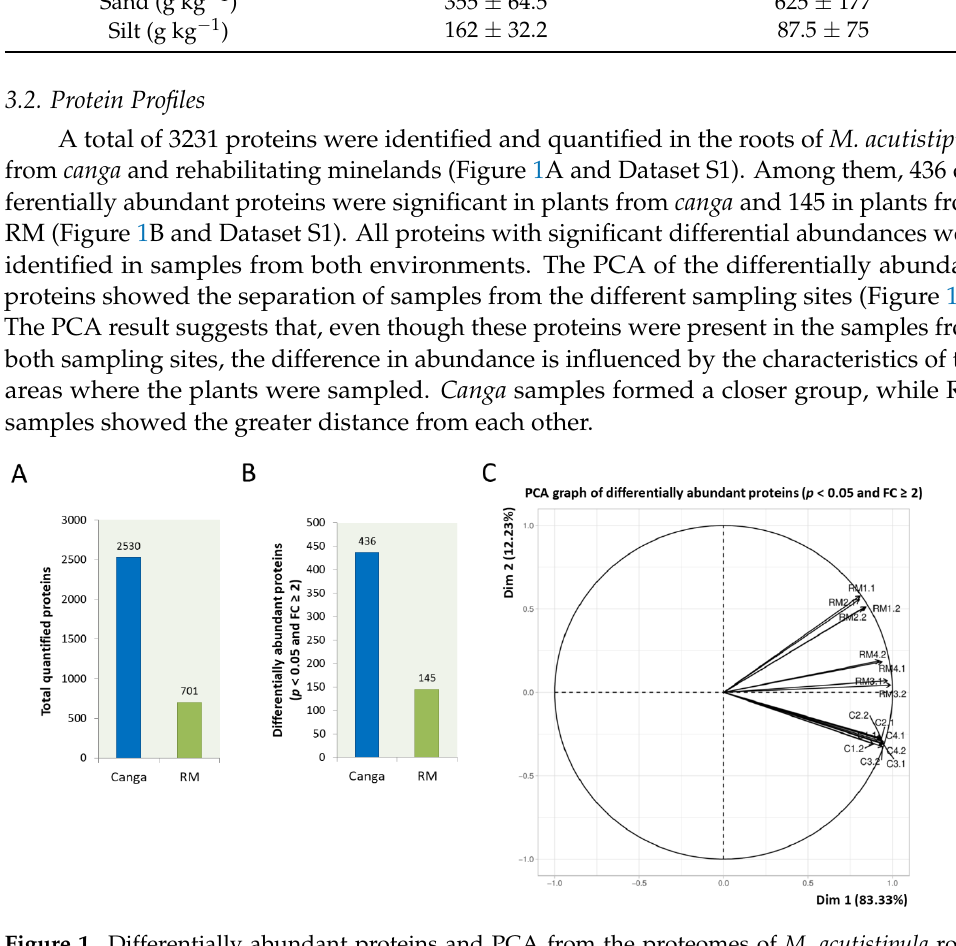
Figure 1. Differentially abundant proteins and PCA from the proteomes of M. acutistipula roots sam- pled in a rehabilitating mineland (RM) and a native shrub canga . ( A ) Total quantified proteins in roots from each environment. ( B ) Number of most abundant proteins in roots from each environ- ment considering a p -value < 0.05 and fold c hange ≥ 2. ( C ) PCA of differentially abundant proteins with p -value < 0.05 and fold change ≥ 2 comparing replicates of roots from RM (RM1.1, RM1.2, RM2.1, RM2.2, RM3.1, RM3.2, RM4.1, and RM4.2) and canga (C1.1, C1.2, C2.1, C2.2, C3.1, C3.2, C4.1, and C4.2). The proteins used for analysis are presented in Dataset S1.